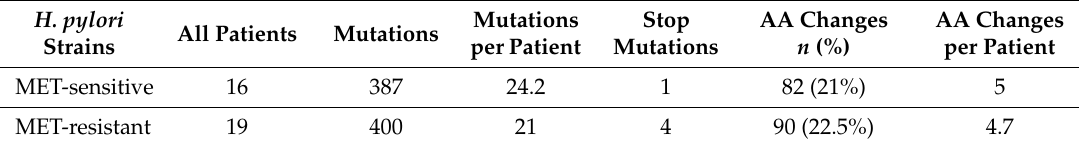
Table 4. Occurrence of point mutations in the rdxA gene in tested H. pylori